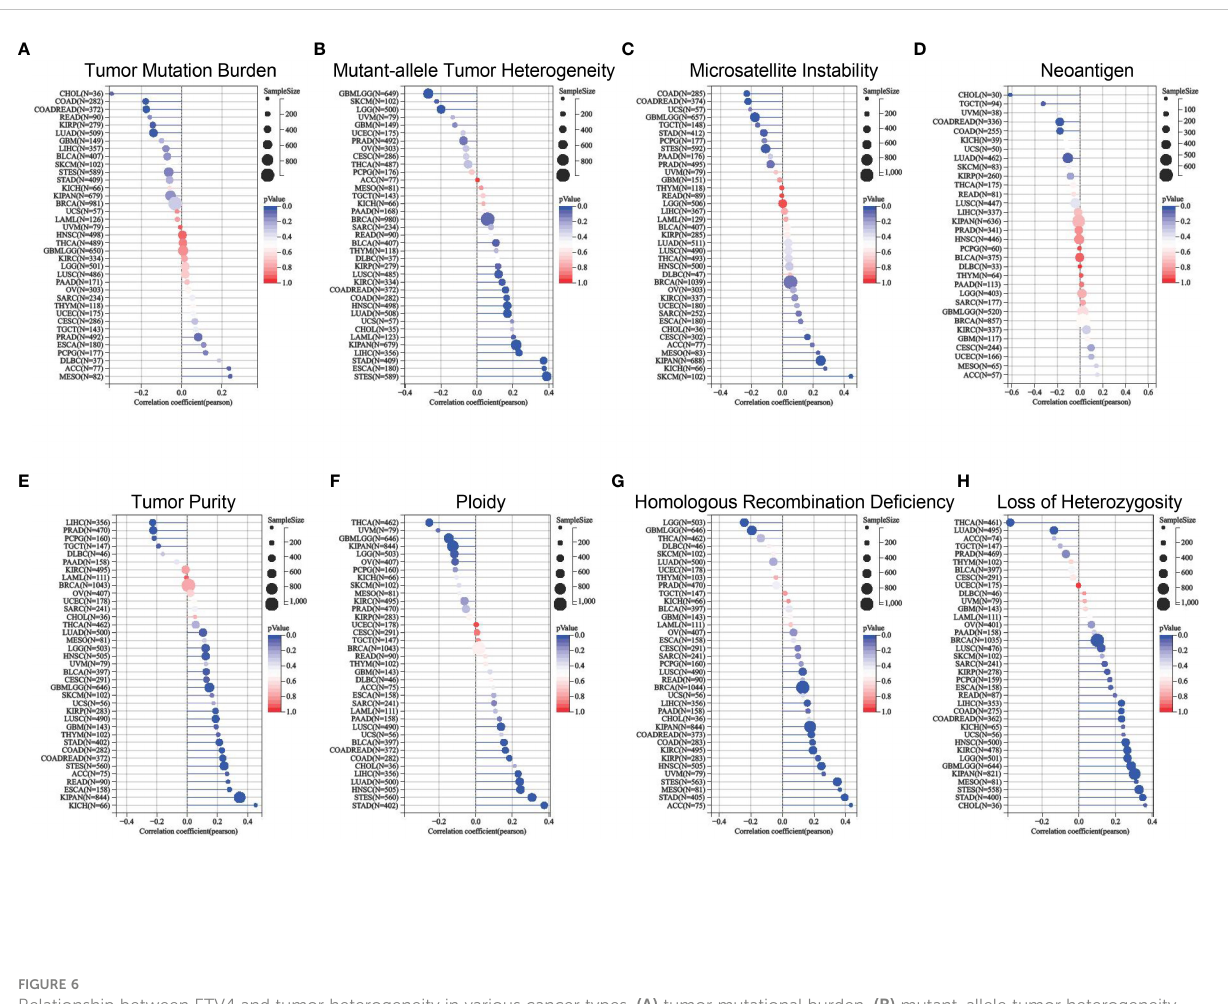
FIGURE 6 Relationship between ETV4 and tumor heterogeneity in various cancer types. (A) tumor mutational burden, (B) mutant-allele tumor heterogeneity, (C) microsatellite instability, (D) neoantigen, (E) tumor purity, (F) ploidy, (G) homologous recombination de fi ciency, and (H) loss of heterozygosity were calculated using data from TCGA